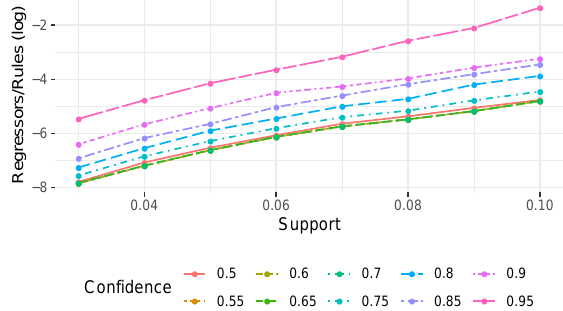
Figure 7. Fraction of obtained models per